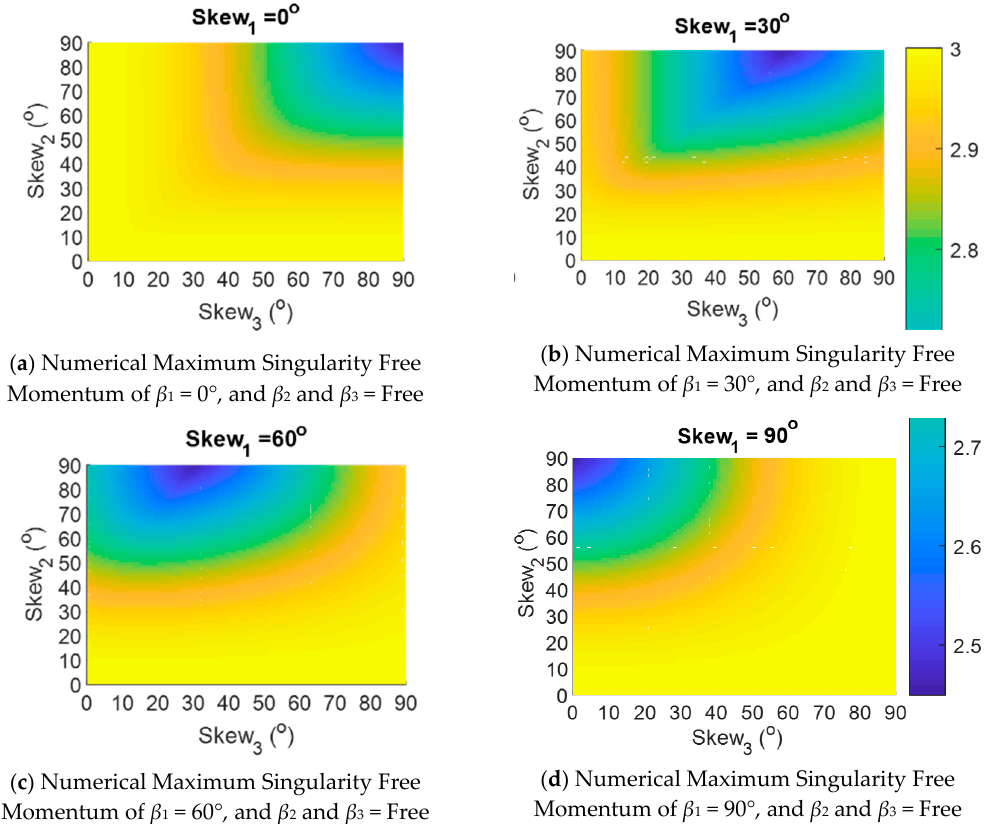
Figure 4. Numerical Maximum Singularity Free Momentum of β 1 = 0°, 30°, 60°, and 90°, and β 2 and β 3 = Free.